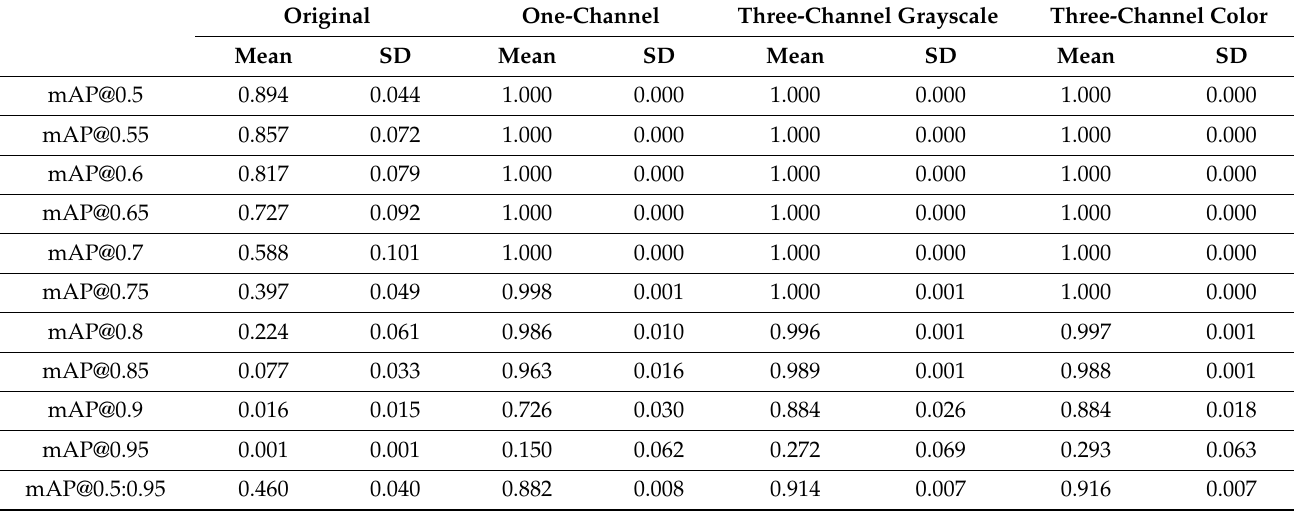
Table 10. YOLOv4 object detection validation results with the augmented